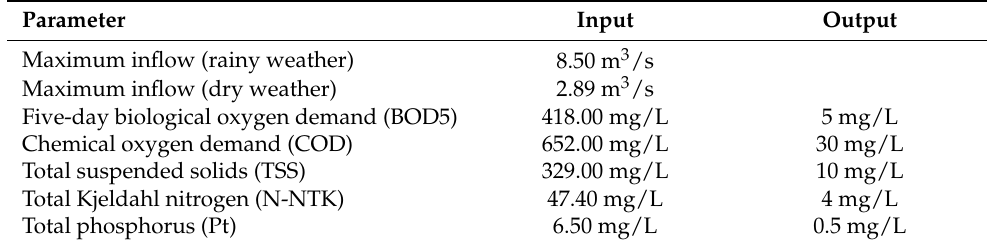
Table 1. Design parameters of the Villap é rez wastewater treatment plant (Asturias, Spain). Parameter